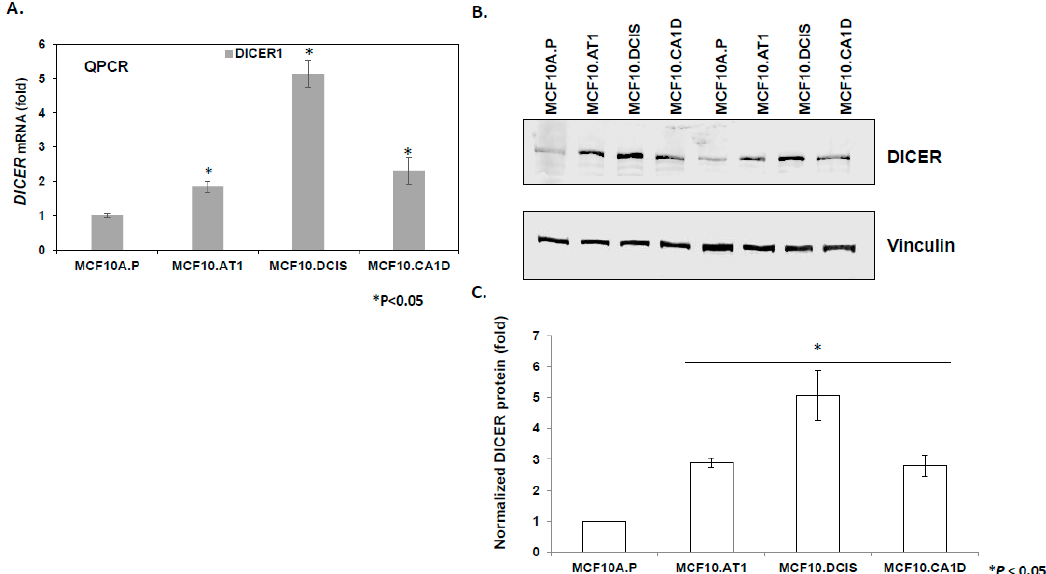
Figure 3. DICER upregulation during breast cancer progression. (A) Relative mean expression of endogenous DICER1 mRNA assayed by qPCR across the MCF10A-based breast cancer progression panel. DICER1 mRNA levels were first normalized to a housekeeping gene, RPL19. The Ct values were converted to fold change using the delta Ct method and setting the lowest gene expression (MCF10A.P cells, in this case) as 1. (B and C) Western blot analysis and its quantification showing upregulation in endogenous DICER1 protein in the breast cancer progression panel. DICER protein levels were normalized to the loading control, vinculin. The relative DICER expression was set as 1 in MCF10A.P cells, and the relative fold change was calculated in other cell lines. The graph represents mean values + SEM. p values were calculated using student’s t test. * indicates p < 0.05.